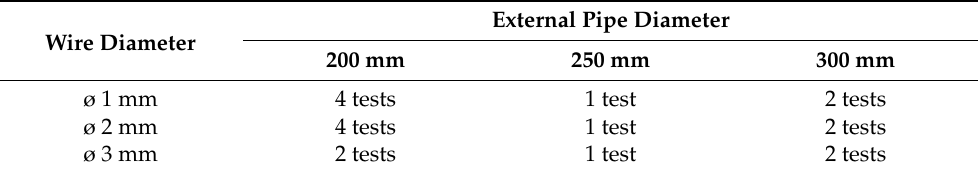
Table 4. Number of tests performed on concrete hollow cylinders with use of SMA wires without preliminary